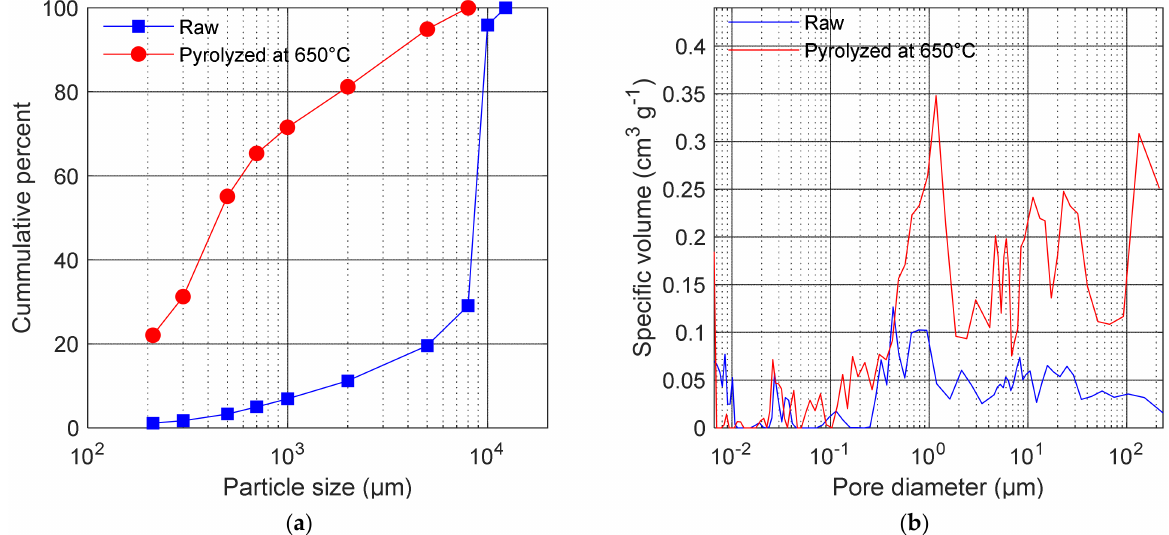
Figure 2. ( a ) Cumulative particle size distribution of the raw sunflower husk pellet (squares) and thermally processed material at 650 ◦ C (circles). The fine fraction of biochar ( φ < 212 µ m) accounts for approximately 20% of the total volume. ( b ) Results of the pore diameter vs. specific pore volume for the raw and pyrolyzed (at 650 ◦ C) material. After the thermal processing, the biomass increased its specific pore volume, which was the most evident above the 0.3 µ m pore